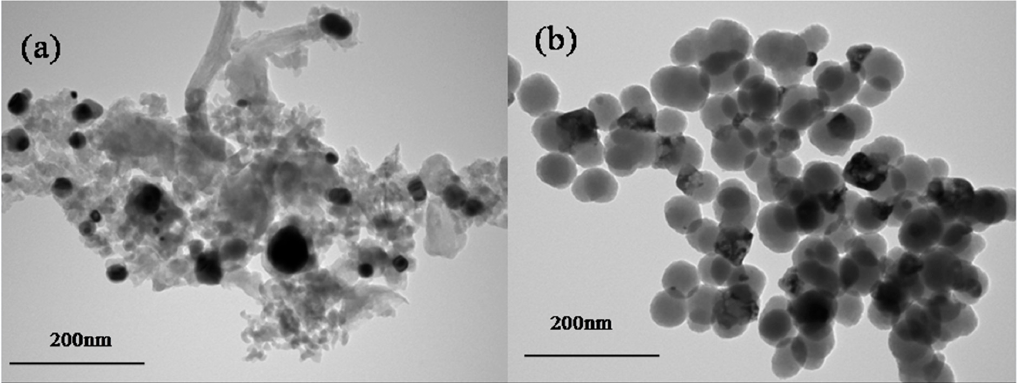
Figure 7. TEM images of used catalysts ( a ) NiO@SiO 2 ; and ( b ) NiO/SiO 2 .